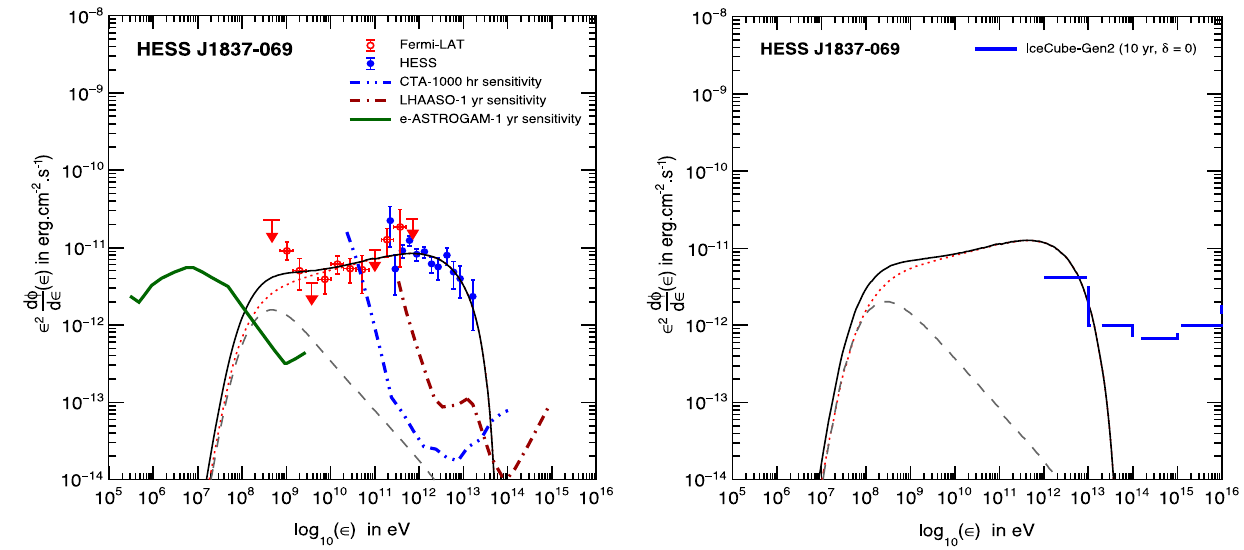
Fig. 4 Left: the estimated differential energy spectrum of gamma-rays reaching the Earth from the PWN HESS J1837-069. The red dotted line represents the gamma-ray flux produced due to the interaction of SNR accelerated cosmic rays with the ambient matter of the PWN. The gray dotted line denotes the background gamma-ray flux from the PWN due to interaction of the Cosmic rays galactic background with PWNmaterial.Theblackcontinuous linerepresents theestimatedover- all differential EM SED from the PWN. The blue dash-double-dotted, brown dash-single-dotted, and green dash-triple-dotted lines represent the detection sensitivity of the CTA detector for 1000 h, the LHAASO detector for one year, and e − ASTROGAM for 1 year, respectively.